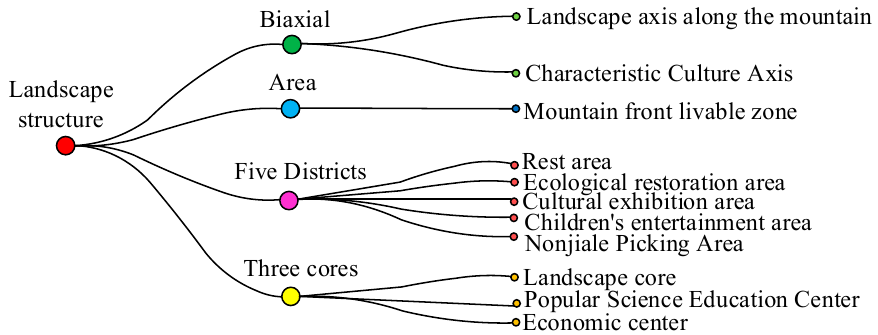
Figure 5. Landscape structure of Lanshan Mountain Ecological Park.